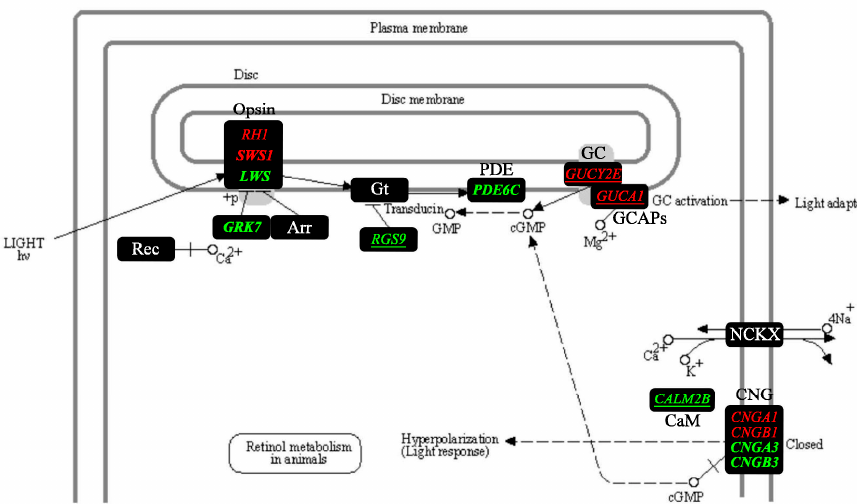
Figure 6. Genes of interest involved in phototransduction pathway (modified from KEGG pathway: map04744). Genes not involved in this study are shown in white. Genes assigned to modules correlated with eyes of A. prasina and L. flavozonatum are shown in green and red, respectively. The genes specifically involved in phototransduction in cones are shown in bold, and in rods shown in regular font, while underlined texts indicate genes in both cones and rods.